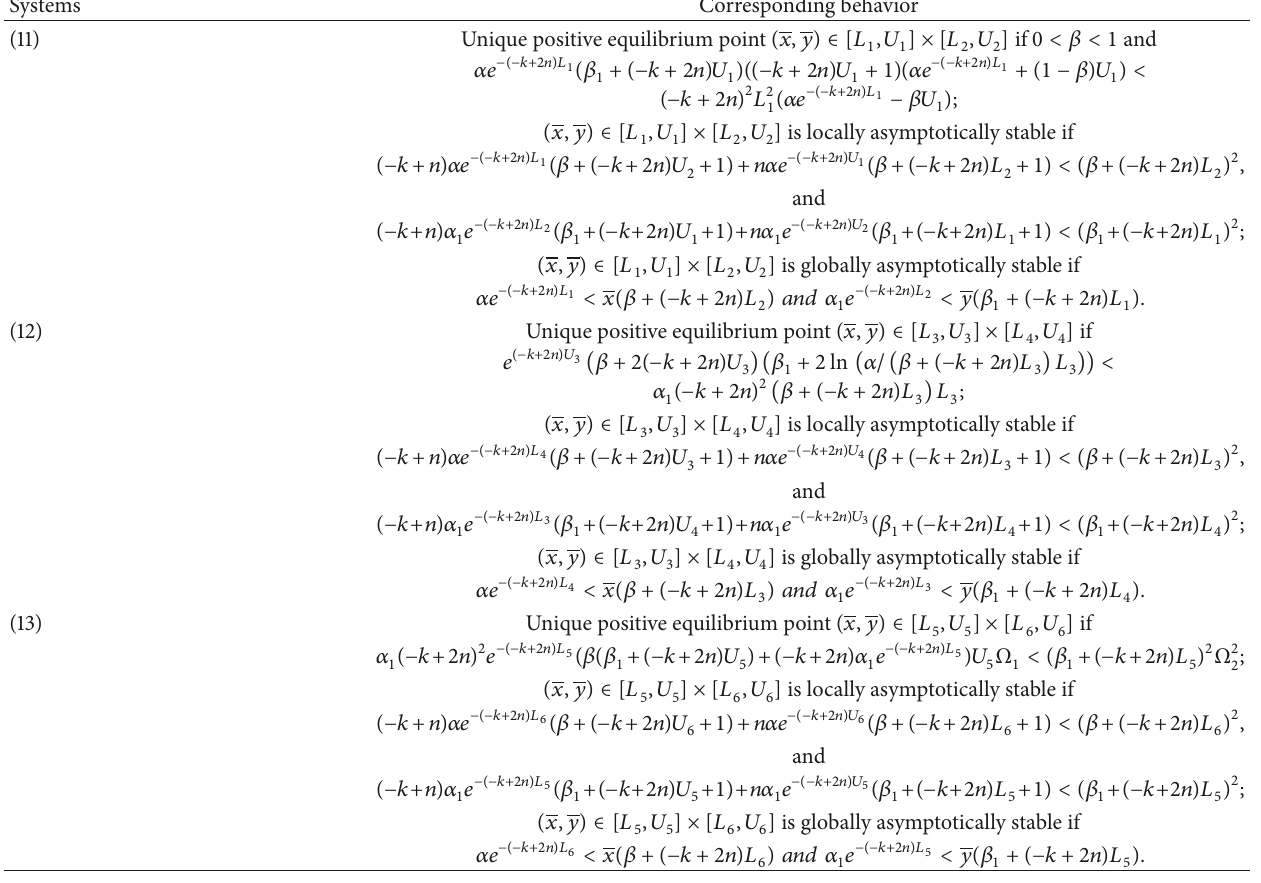
Table 1: Systems with corresponding qualitative